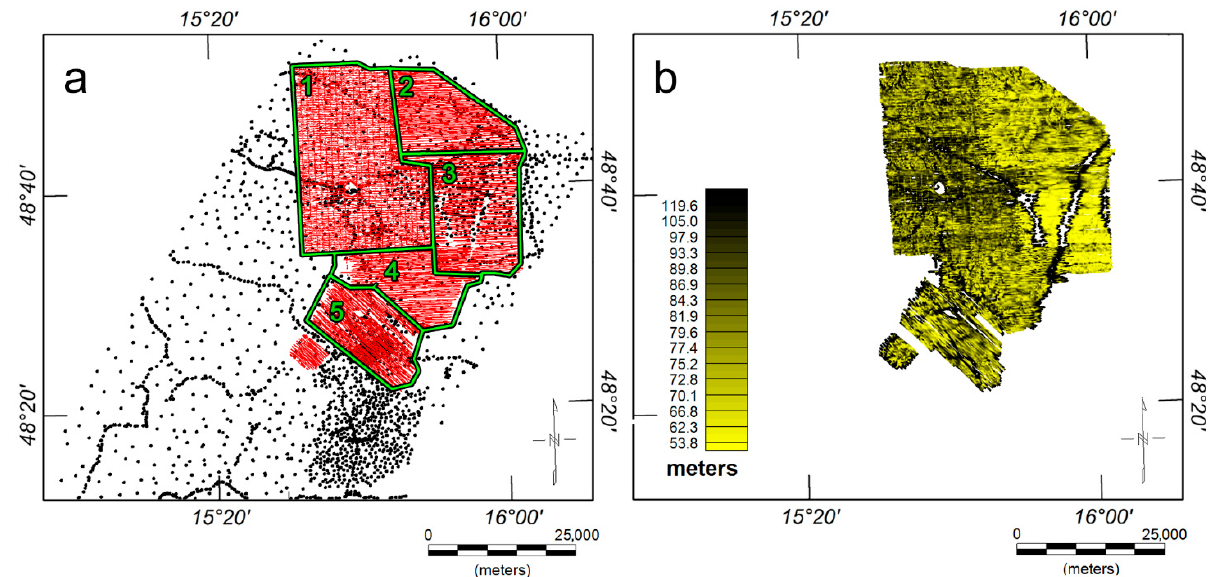
Figure 2. Survey layouts. ( a ) Acquisition points of gravimetric data (unevenly distributed in black) and acquisition lines of airborne data (in red); measurement areas: 1: Geras, 2: Pulkau north, 3: Pulkau, 4: Kamptal-Ziersdorf 5: Kremser Bucht; ( b ) clearance of the airborne data.